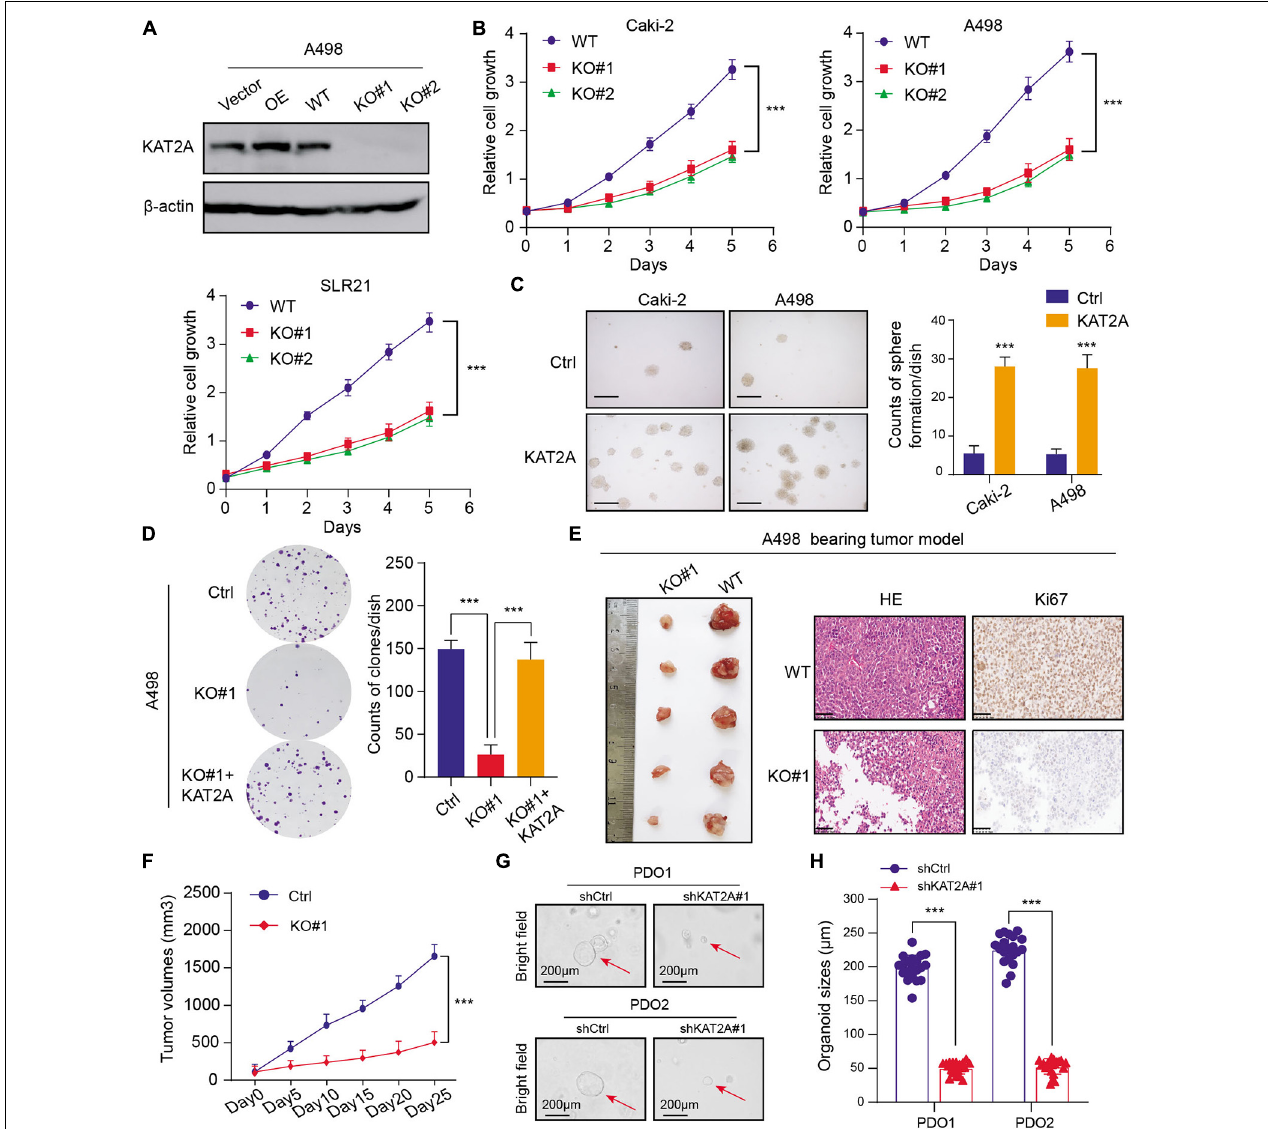
FIGURE 2 | Functional assays validated that KAT2A promoted proliferation of RCC in vitro and in vivo . (A) The protein levels of KAT2A in A498 cells with KAT2A overexpression or deficiency were validated via Western blotting. (B) CCK-8 assays were performed to reveal that KAT2A deficiency could significantly suppress the in vitro growth of RCC cells, including Caki-2, A498, and SLR21. (C) KAT2A overexpression could significantly promote the growth of RCC cells revealed by the 3D soft-agar colony formation assay. (D) The clonogenic efficiency in A498 cells with wild type or deleted KAT2A was determined, and KAT2A restoration could completely rescue the impaired growth ability (left). Quantification of the colony formation assay results (right). (E) KAT2A deficiency effectively suppress the RCC subcutaneous tumor growth in nude mice ( n = 5) versus the control group (left). The representative HE slides and matched intra-tumor Ki67 staining were shown (right). (F) The tumor volumes in two groups were measured in the indicated days, and the serial tumor growth curves were generated. (G) Representative pictures of two independent RCC organoids transfected with shRNAs targeting KAT2A or control lentivirus for 21 days. The quantification of organoid diameters (right panel) was shown as the means ± SD. (H) Quantification of organoid sizes of the PDOs. *** P <